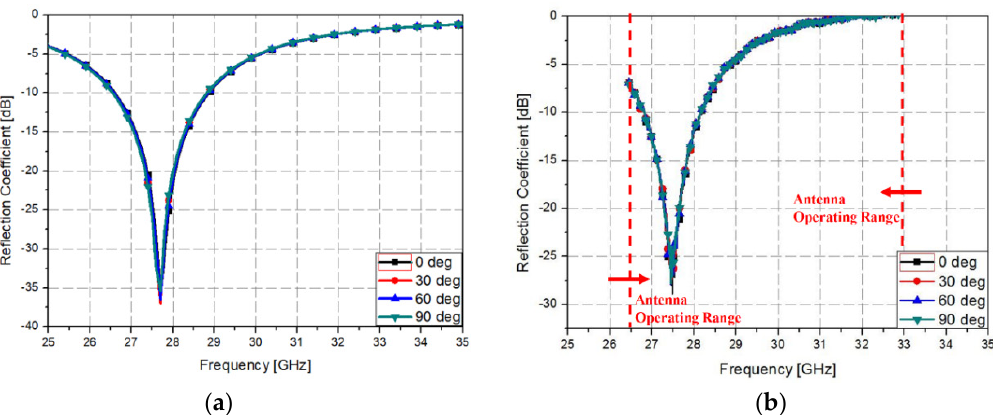
Figure 9. Comparison graph between simulation and measurement results: plots of ( a ) reflection coefficient and ( b ) absorptivity versus the frequency.